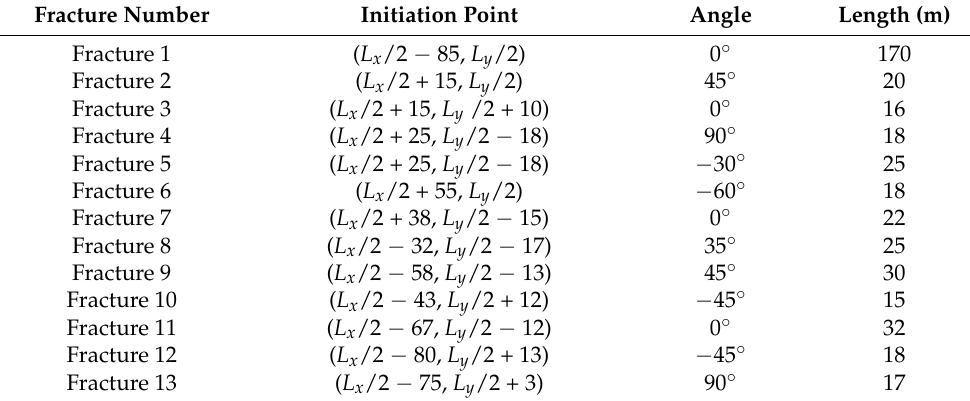
Table 1. Model Table 1. Model parameters.